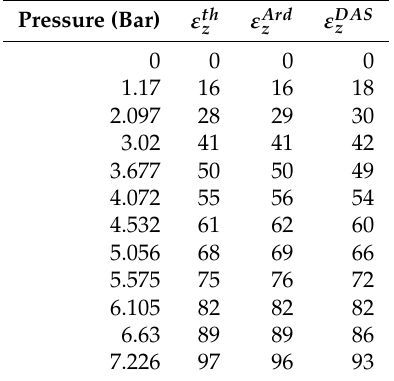
Table 2. Longitudinal deformation measurement (in microns) by different techniques vs. Pressure. ε th z , theoretical values; ε Ard z , SmartFire; ε DAS z , data Acquisition